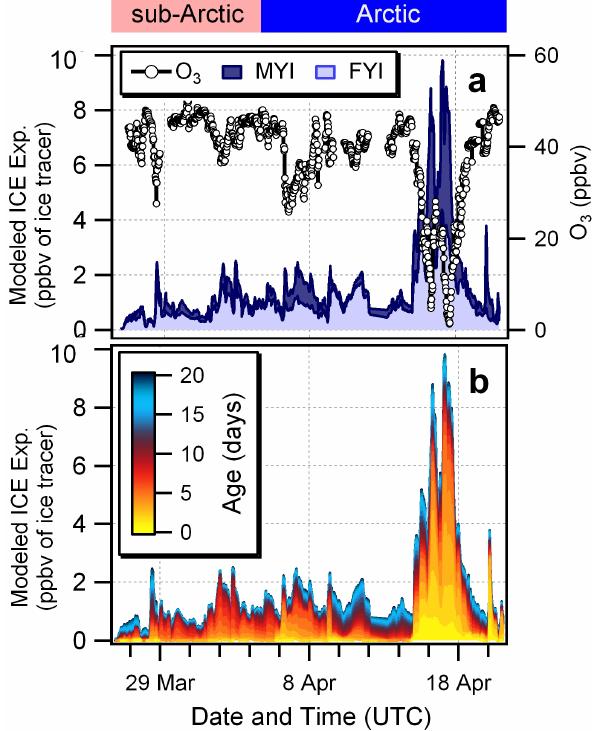
Fig. 5. (a) Time series of O 3 and the modeled FYI and MYI ex- posure for the sub-Arctic and Arctic data subsets from ICEALOT. MYI has been stacked on FYI so that the combined height repre- sents the total ICE (FYI + MYI) exposure. (b) Time series of total ICE exposure colored by FLEXPART